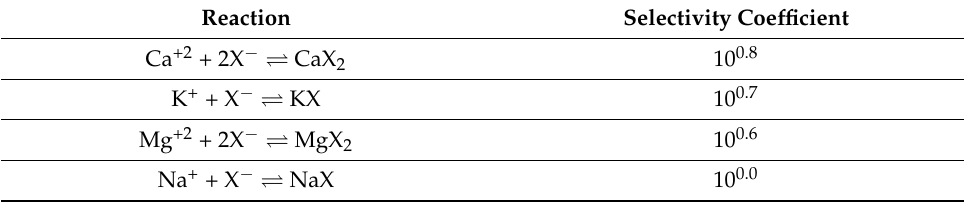
Table 3. Different ion exchange reactions along with selectivity coefficients at 25 ◦ C